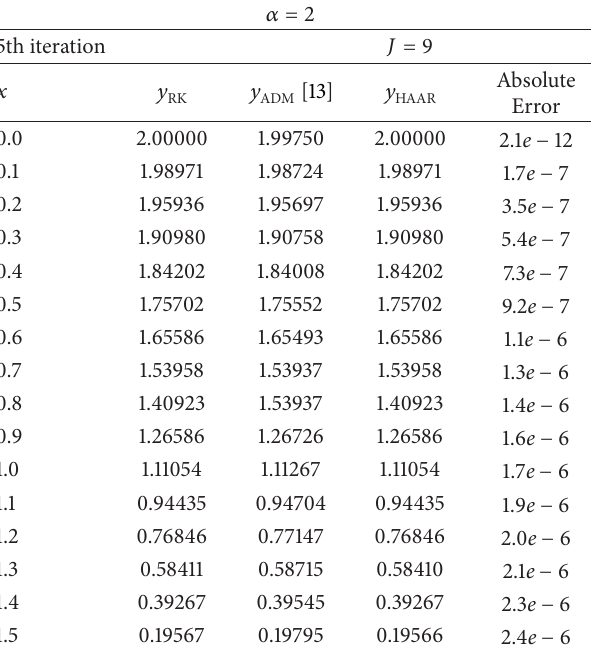
Table 4: Force-free Duffing-Van der Pol Oscillator Equation: comparison of solutions by the Haar wavelet-quasilinearization at 5th iteration and level of resolutions 𝐽 = 9 with technique 𝑦 HAAR [13] and numerical solution based on decomposition method 𝑦 ADM the fourth-order